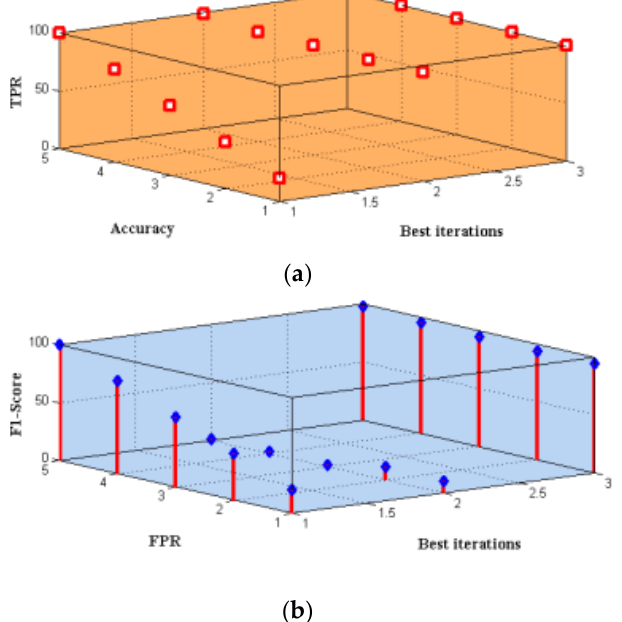
Figure 11. ( a ). Accuracy with respect to best iterations and ( b ). F1-score with respect to best iterations.